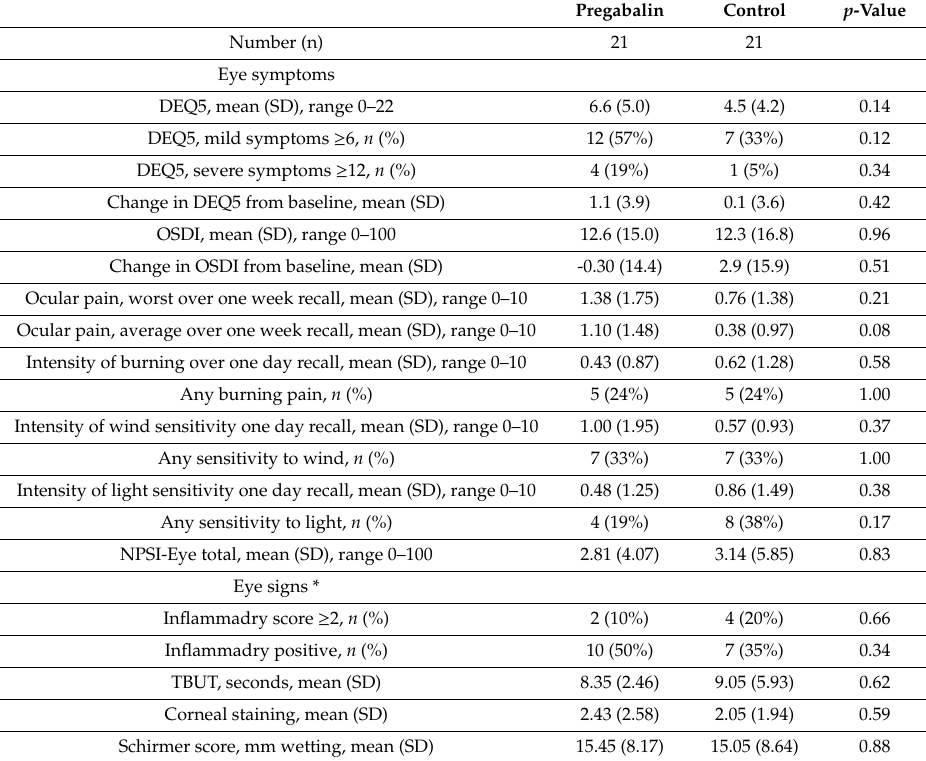
Table 3. Ocular symptoms and signs at six months post-LASIK, by treatment assignment.